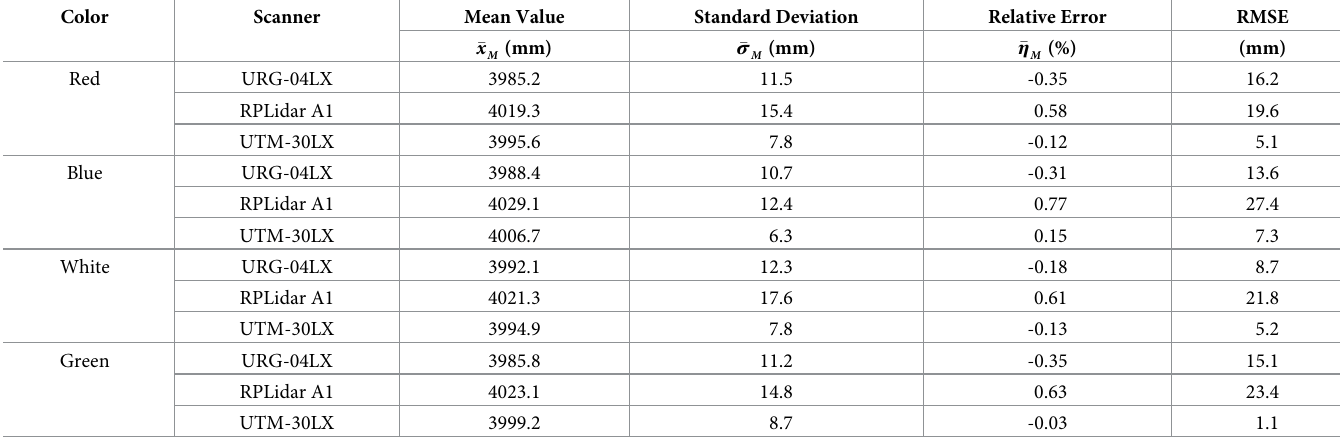
Table 8. Impact of color variations on range